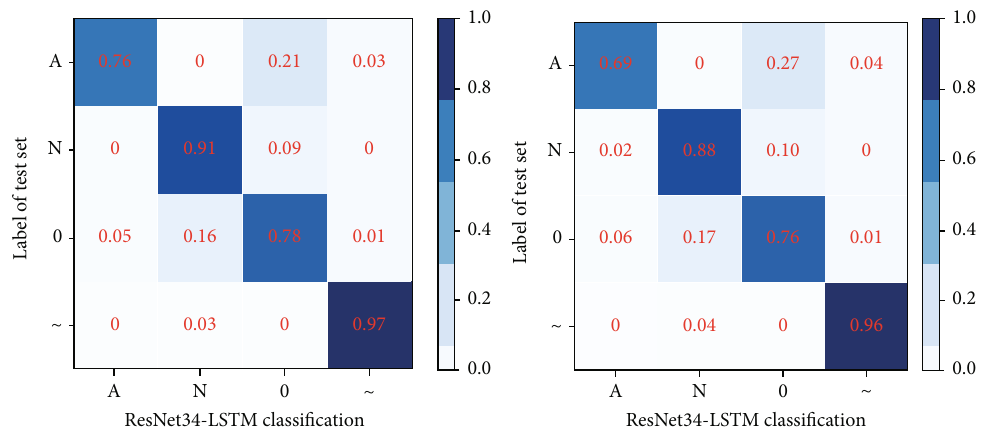
Figure 10: Comparison of the ResNet34-LSTM3 and ResNet34 confusion matrix.